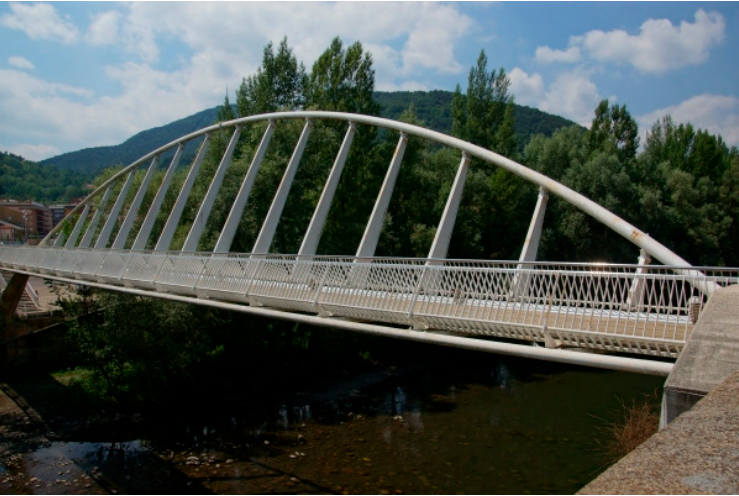
Figure 6. La Alameda bridge. (See Tzonis [17], Jorquera-Lucerga [18] and Jodidio [19]). Photo: J.J. Jorquera-Lucerga. Therefore, since stiff hangers are an efficient way to reduce internal forces and deflections both in the arch and in the deck, they can be considered as a tool for the designer, who can decide to use them within a more general design process. In Figure 8, the effect of stiffening the hangers in the reference bridge is shown, both for loads distributions upon half ( q 1 ) and the whole deck ( q 3 ). Regardless of the load case, it can be seen how the bending moments are always smaller for the bridge with stiff hangers. All the internal forces and deflections diagrams shown in this paper have been obtained with SAP2000 (see Computers and Structures, Inc. [20]).